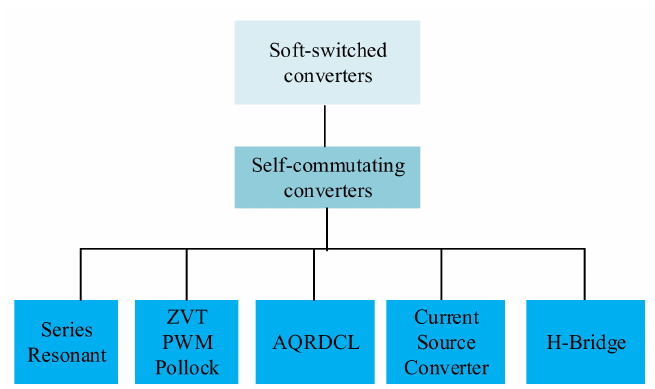
Figure 14. Soft-switched converters edited from